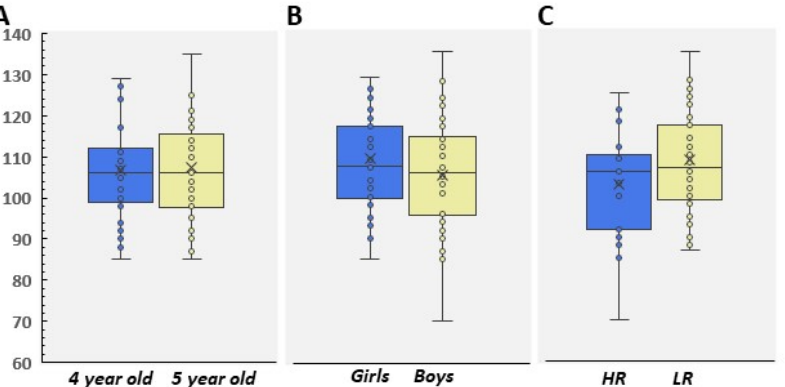
Figure 8. ( A ) Mean neurodevelopmental coefficient distributed by ( A ) age (4- and 5-year-old children); ( B ) gender, and ( C ) LR and HR group. HR scores are shown according to the high responder to the pig or to the bag. Table 1. Results recorded in the LR and HR groups in the CUMANIN test. The areas evaluated in the table were used to reach an index of neurological maturation according to chronological age. The asterisk indicates the areas where HR showed a significantly lower score than the LR group. Profile Std Error Profile Mean Std